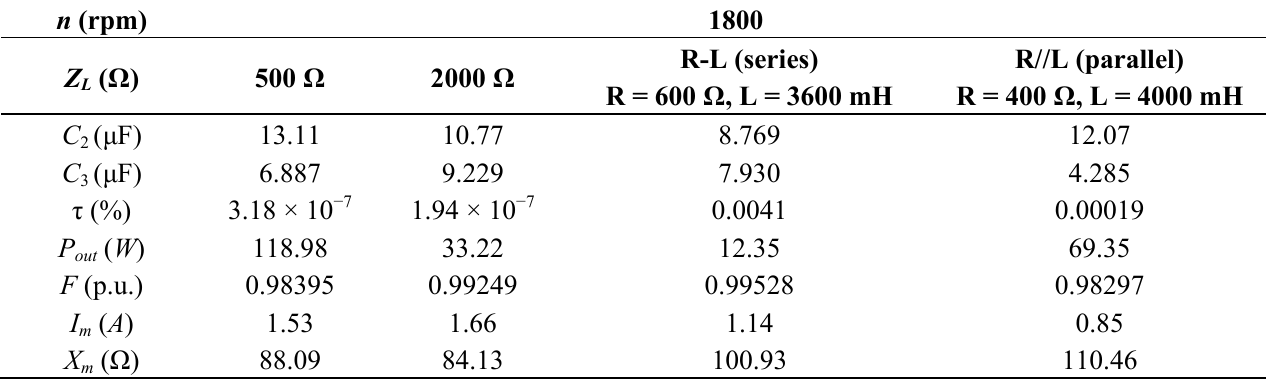
and C for different load impedances at a speed of n = 1800 2 3